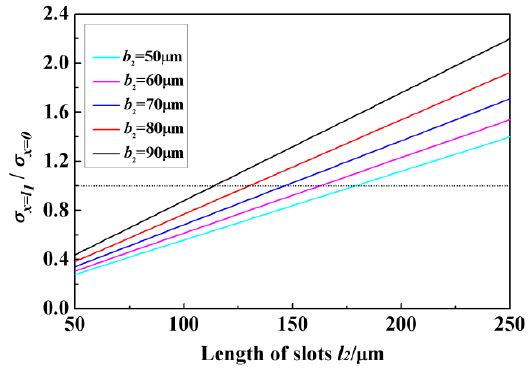
/ σ value versus length of slots l x = l 1 x =0